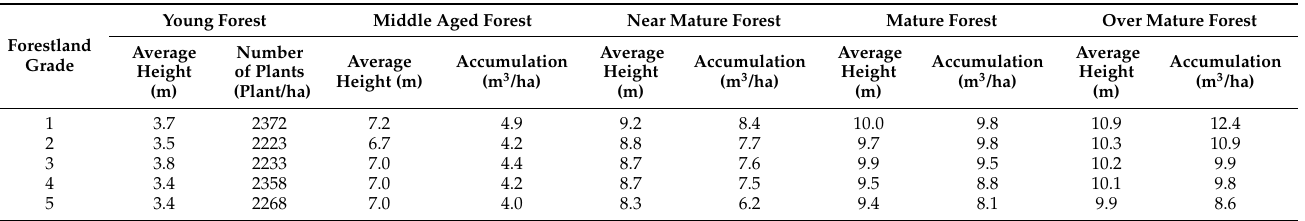
Table 5. Table of average tree height together with volume per unit area divided by number of plants per unit area in different forestland Grades in Longquan County.